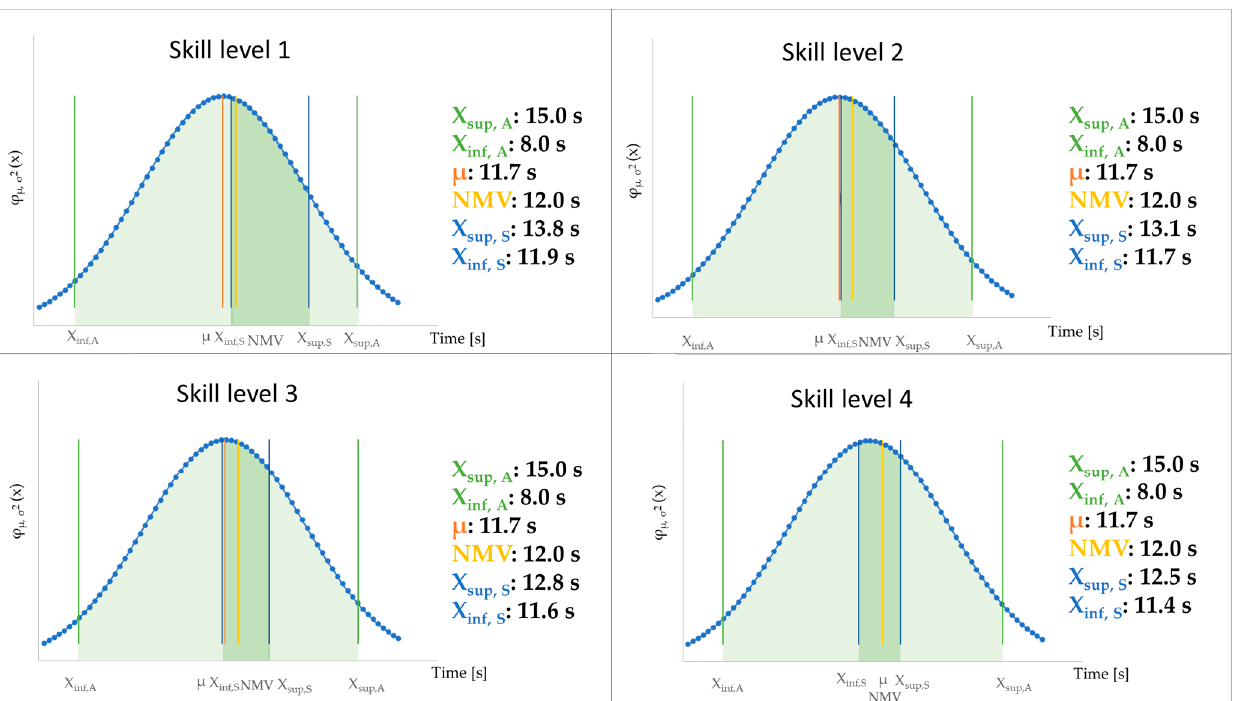
Figure 14. Gaussian distribution of the grasping in workstation A.